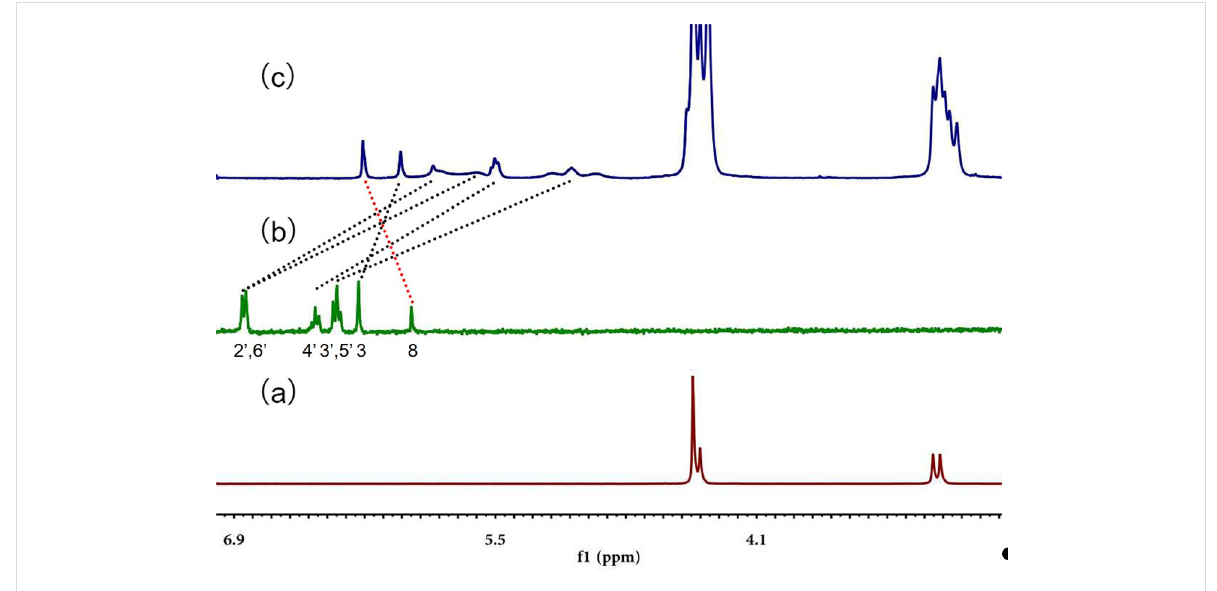
Figure 3: 1 H NMR spectra (400 MHz) of Q[8] (a), baicalein (b) and BALE–Q[8] (1:1) (c) recorded in DCl.